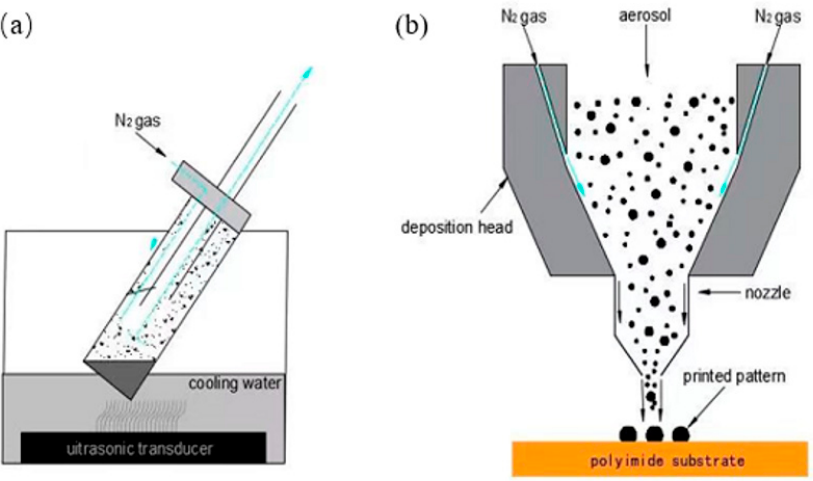
Figure 12. Schematic diagram of the working principle of the jet printer: ( a ) atomization of ink, ( b ) inkjet process.